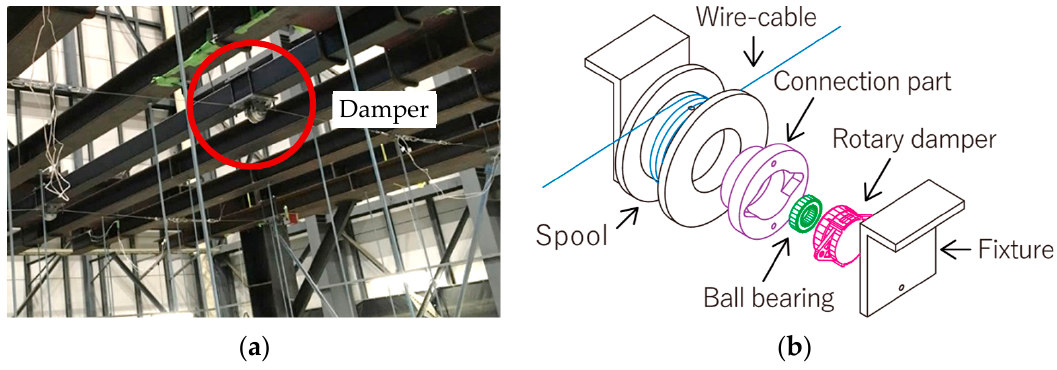
Figure 8 . ( a ) Overview of the damper attached to the supporting beam in the specimen; ( b ) details of the damper components.